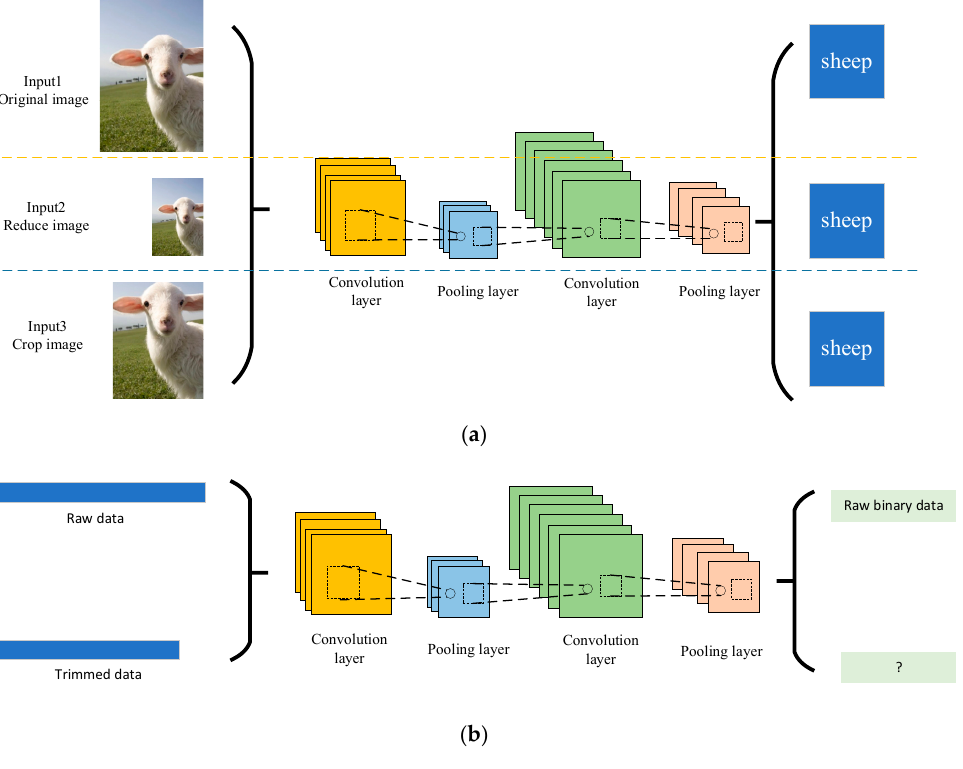
Figure 8. Data cutting idea. ( a ) CNN recognition under different input data. ( b ) Data clipping idea at transmitter.